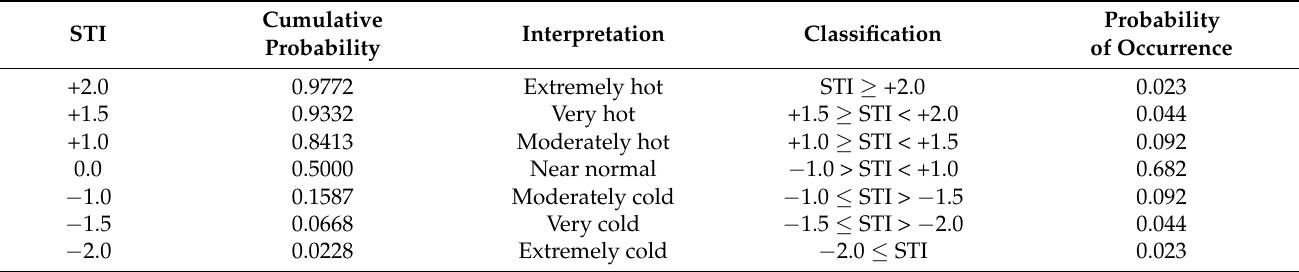
Table 3. Classification of heat categories based on STI